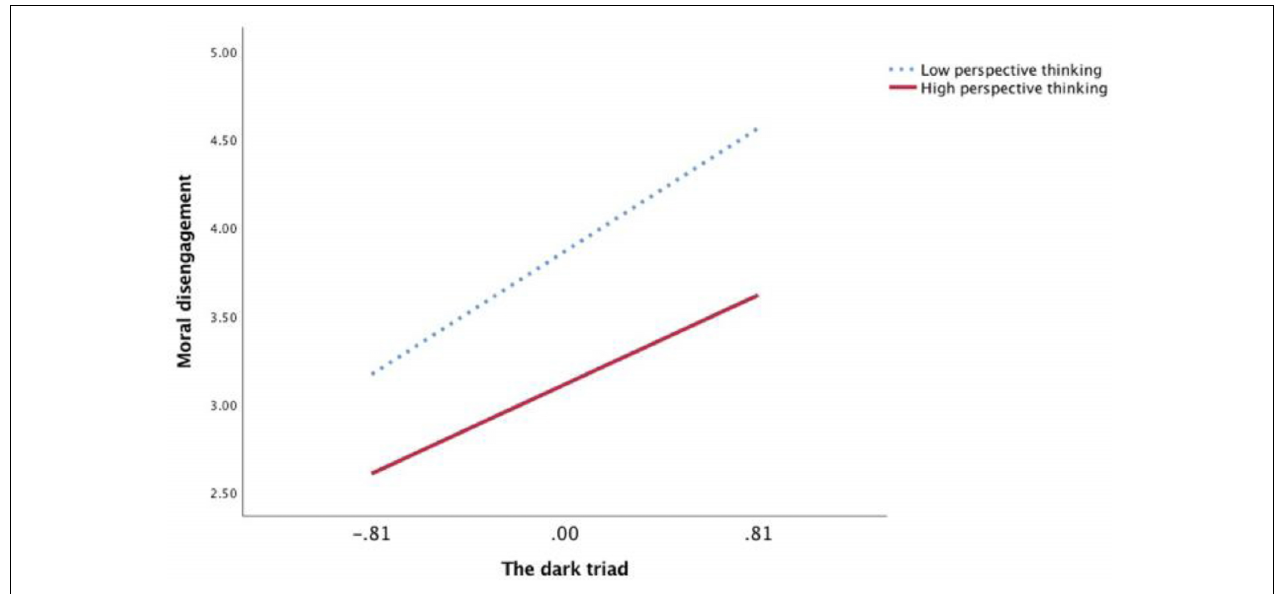
FIGURE 3 | The moderation effect of perspective taking in Study 1. TABLE 3 | Mean, standard deviation, Pearson zero-order correlation, and the discriminant validity test of Study 2. Variable